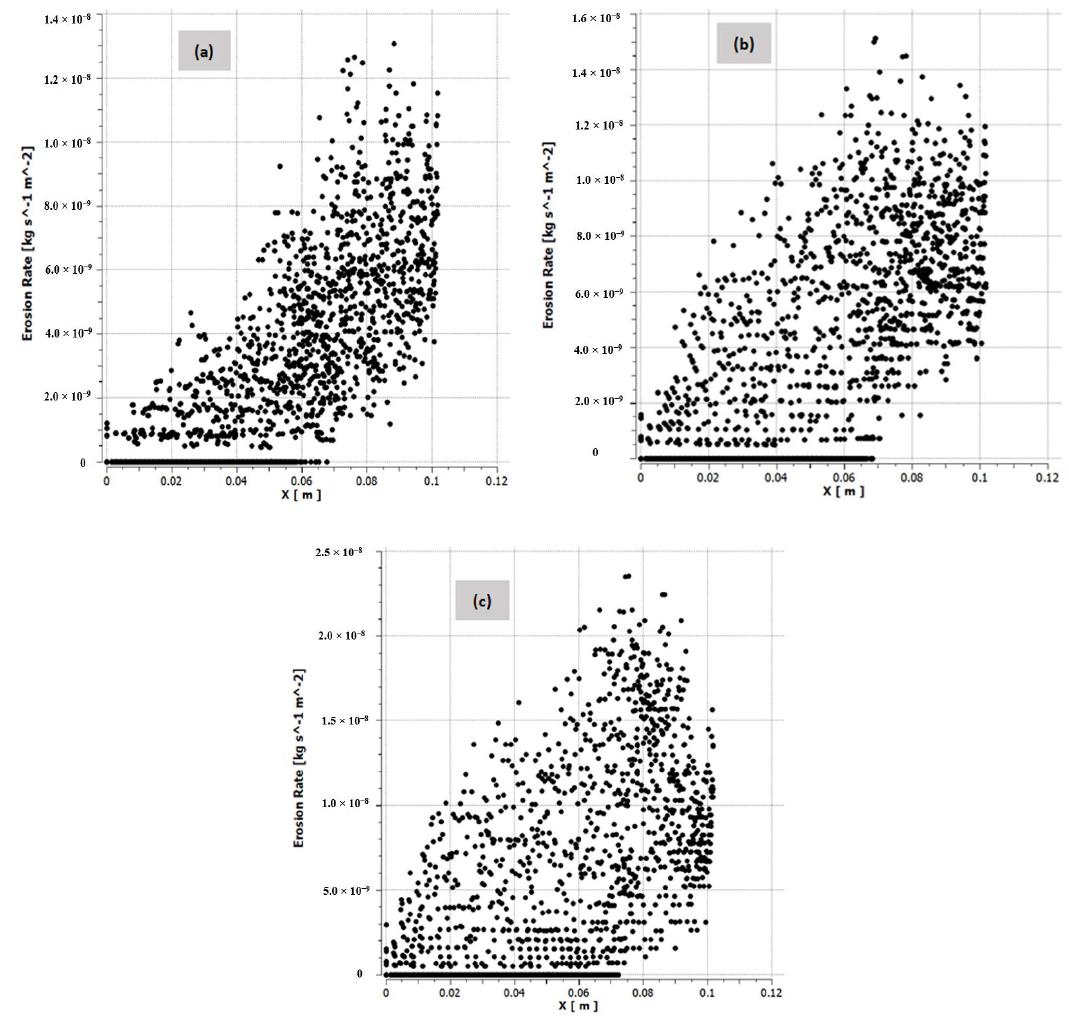
Figure 14. DPM Erosion rate distribution for different flow velocity in 90° carbon steel elbow ( a ) 0.5 m/s ( b ) 1 m/s ( c ) 2 m/s.